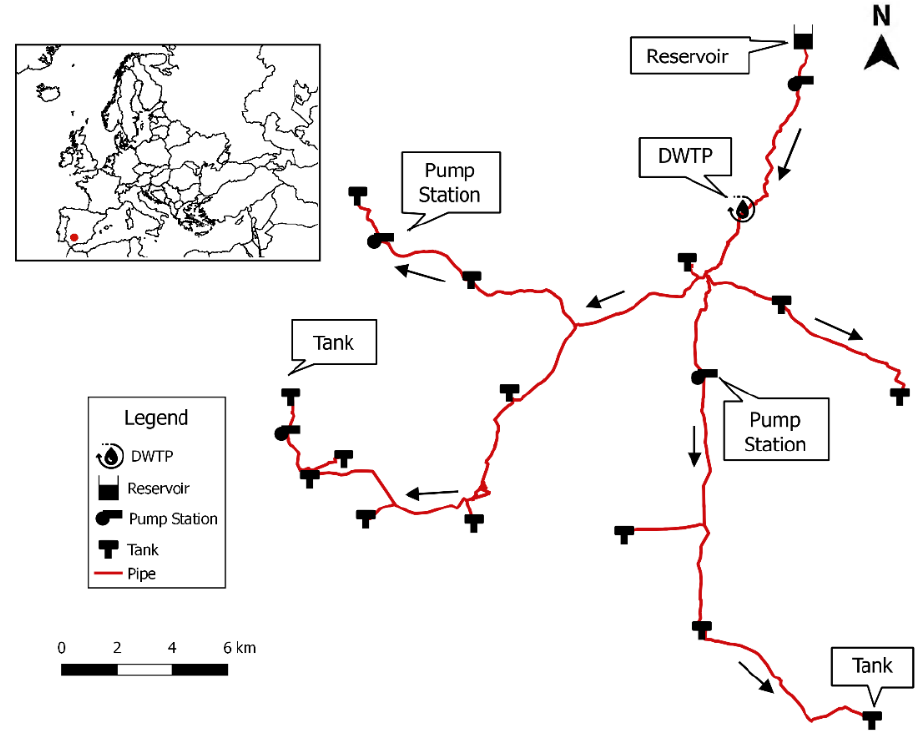
Figure 10. Location and layout of the hydraulic network studied.